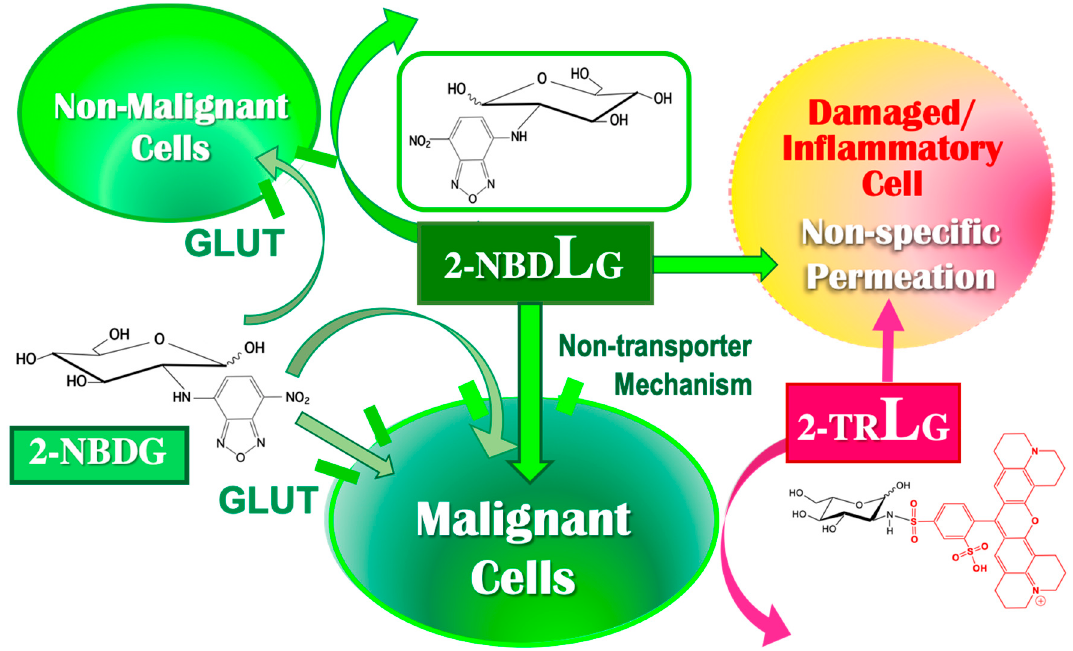
Figure 6. Schematic representation of uptake of fluorescence-emitting D - and L -glucose tracers. Although 2-NBDG enters both non-malignant and malignant cells, 2-NBDLG enters malignant cells only, when plasma membrane integrity is preserved. 2-TRLG is used to identify cells in which 2-NBDLG is taken up due to a loss of membrane integrity. Modified from Yamada, K. Biol. Pharm. Bull. Vol. 41 No. 10. Front cover (Copyright 2018 The Pharmaceutical Society of Japan).